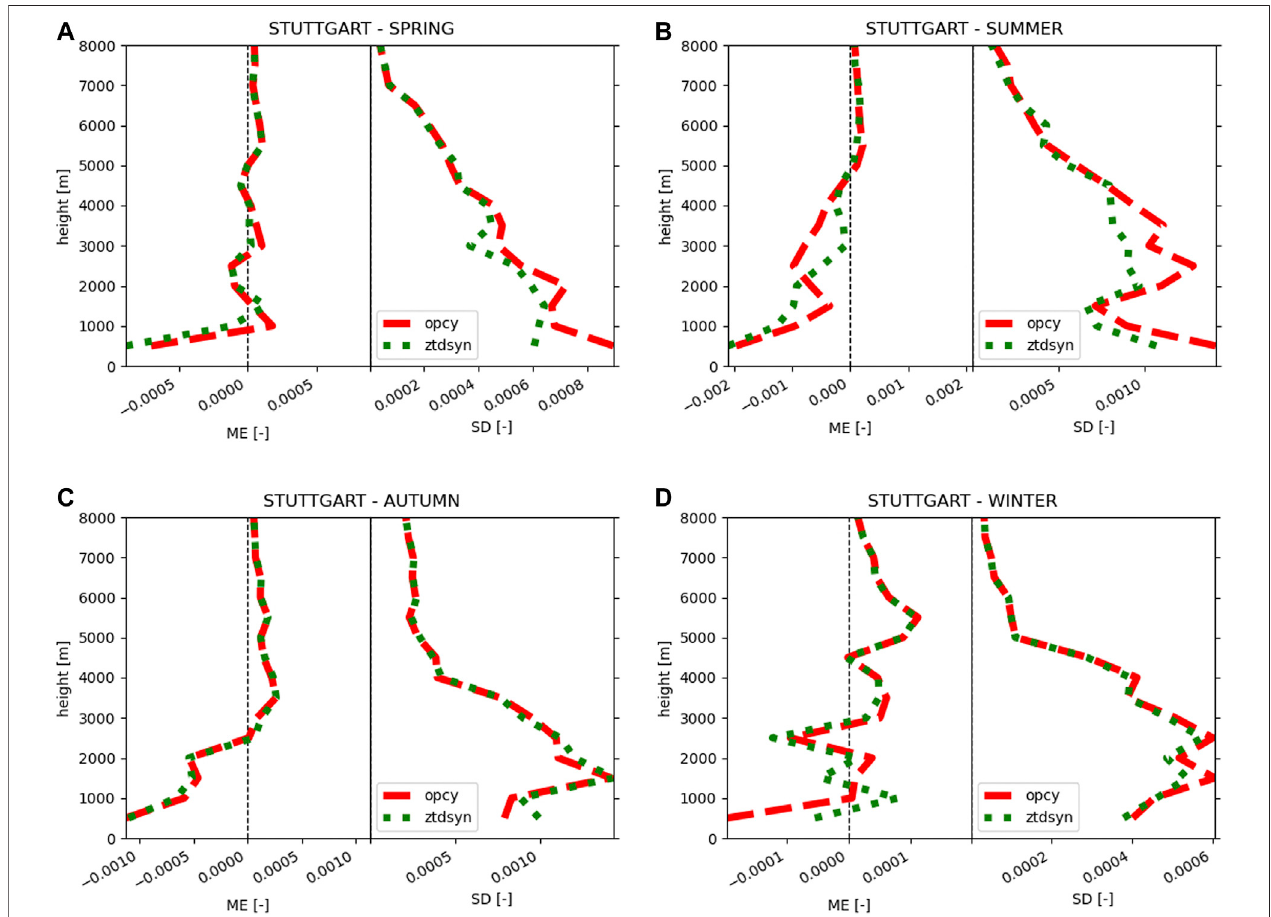
FIGURE 11 | As in 4, but for the open cycle simulation (red) and the assimilation of ZTD and synoptic data (green) in spring (A) , summer (B) , autumn (C) and winter (D) .